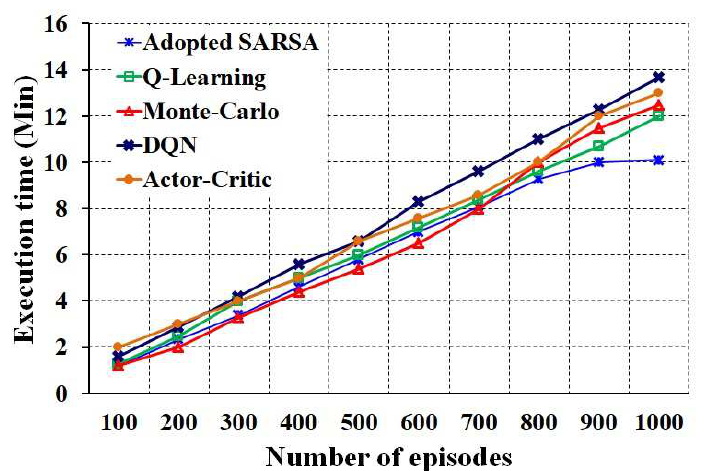
Figure 10. Execution time